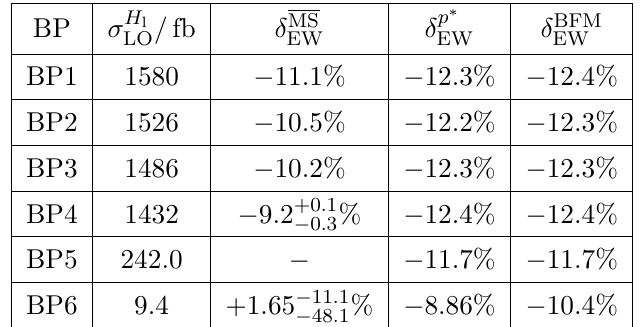
Table 11. Relative NLO corrections (cid:14) EW to light Higgs-boson H l production in Higgs strahlung pp H l (cid:22) (cid:0) (cid:22) + in the HSESM. The scale uncertainties in the MS scheme are estimated including the ! RG running of parameters as given by (6.7). The central scale for BP1{4 is (cid:22) 0 = 2 M h = 250 : 18 GeV. For BP6 we set the scale to (cid:22) 0 = 130 GeV. For BP5 the MS scheme is unstable. The scale uncertainties for BP1{3 are smaller than the given accuracy.